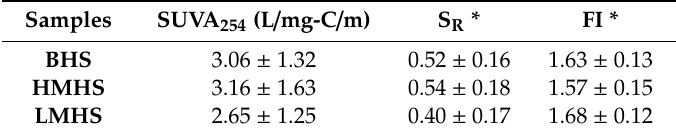
Table 1. Optical indicators of three sized soil humic substances solutions ( n =